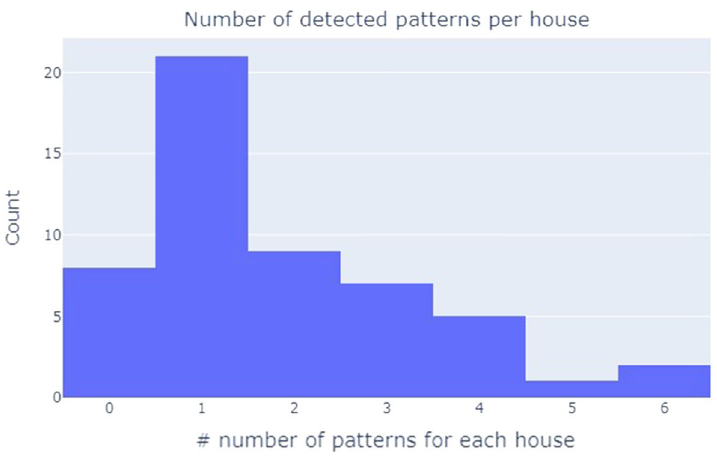
Fig. 4 Distribution of the number of clusters detected per house